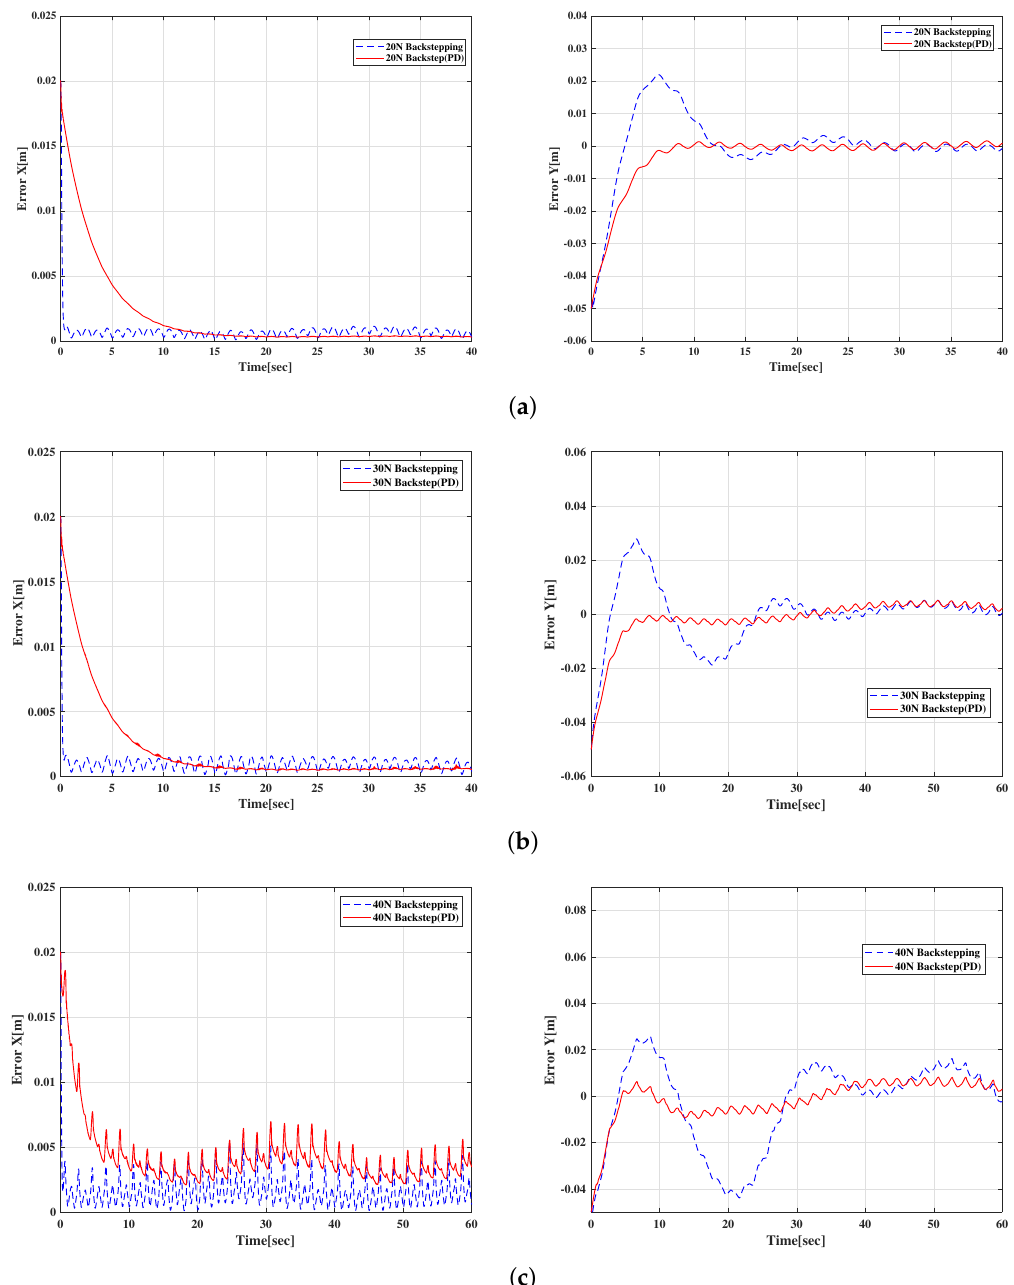
Figure 8. Position errors with variable brush interaction forces. ( a ) Force = 20 N; ( b ) Force = 30 N; ( c ) Force = 40